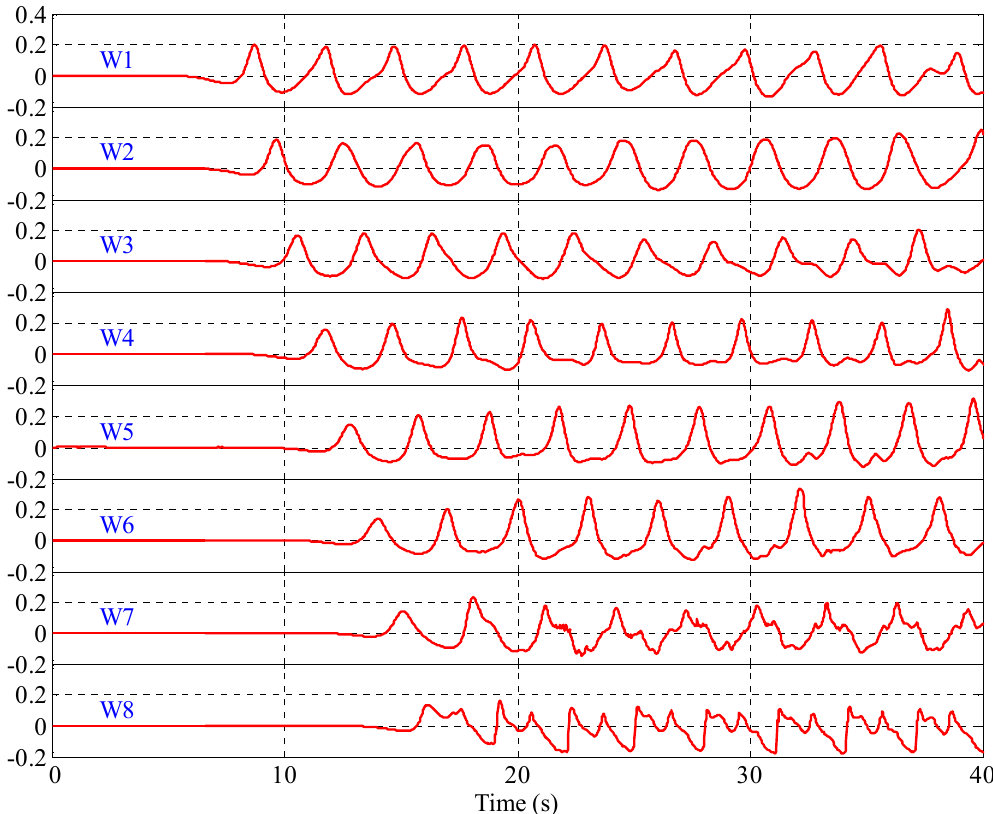
Figure 5. Wave profiles recorded in Test 3 ( d = 0.71 m, H = 0.3 m, T = 3.0 s).